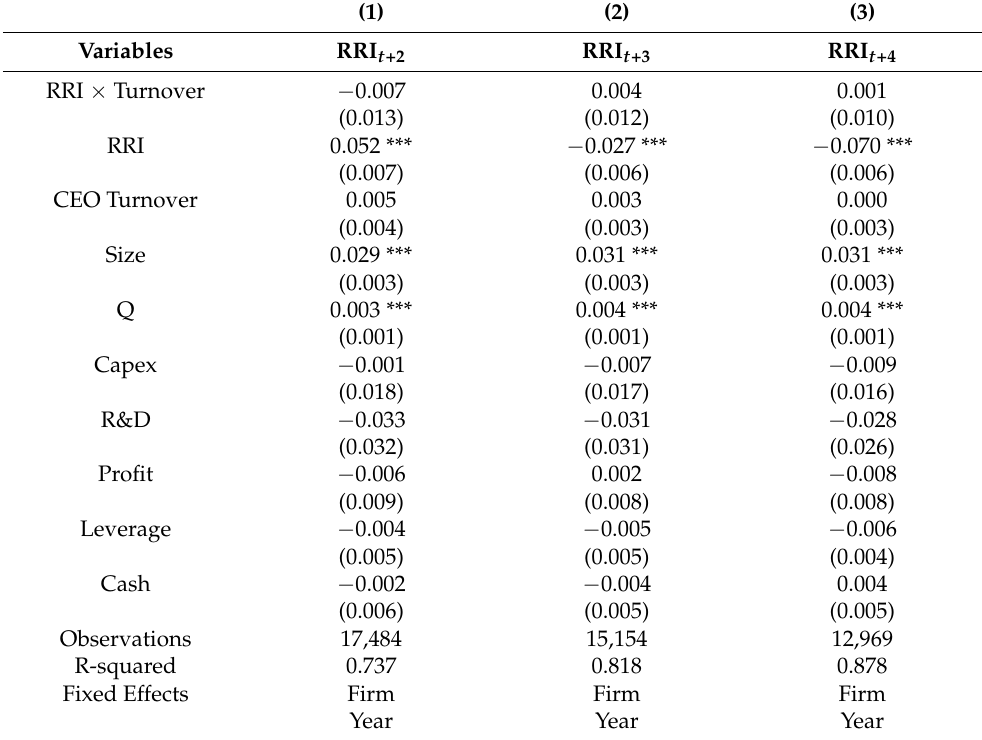
Table 8. Does turnover impact RRI in subsequent years? The dependent variable for columns (1)–(3) are the firm’s average reputational risk index (RRI) over the subsequent 2, 3 and 4 years. See Appendix A for variable definitions. Standard errors are clustered by firm and standard errors are reported in parentheses. *, ** and *** represent statistical significance at the 10%, 5% and 1% level,